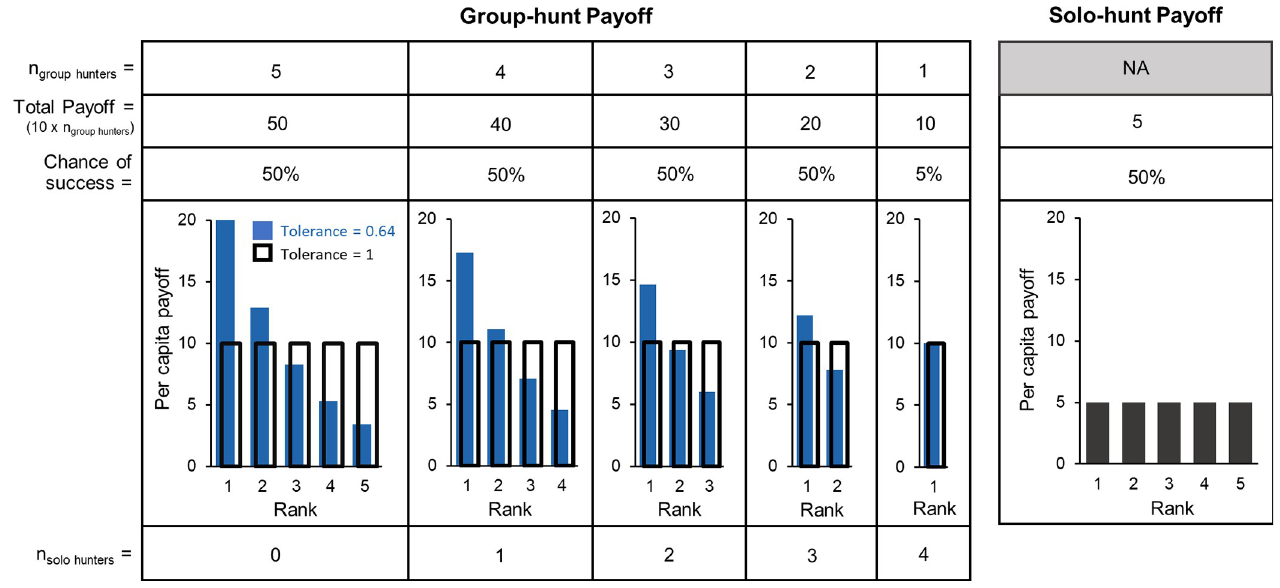
Fig 2. Per capita payoffs under different experimental conditions. Payoff scheme agents received for group hunting and solo hunting under different tolerance conditions (when the group-hunting payoff is 2 times the per capita payoff from solo hunting). Agents hunted in groups with four other agents and each agent decided whether to group hunt (i.e., hunt for large prey and share the reward with other agents that choose to group hunt) or solo hunt (i.e., hunt for small prey and the agent gets a smaller reward that is not shared). If an agent chose to group hunt, the payoff it received depended on its relative rank among other group hunters, the tolerance value, and how many other agents chose to group hunt. Agents received equal shares of the group-hunting payoff when tolerance = 1. As tolerance decreased, the payoff was increasingly skewed by dominance rank, with the highest-ranking agent receiving a greater proportion of the payoff. Agents received the same payoff from solo hunting regardless or rank under all tolerance